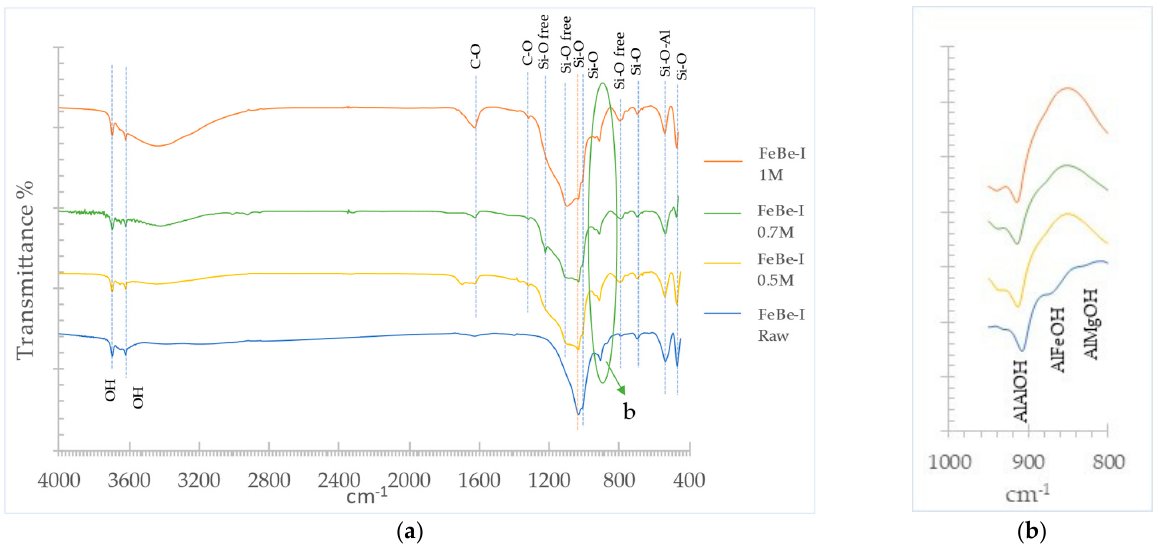
Figure 7. FT − IR spectra of FeBe-I smectite (raw and activated with 0.5, 0.7 and 1 M oxalic acid). ( a ) Full spectra; ( b ) section 1000–800 cm − 1.